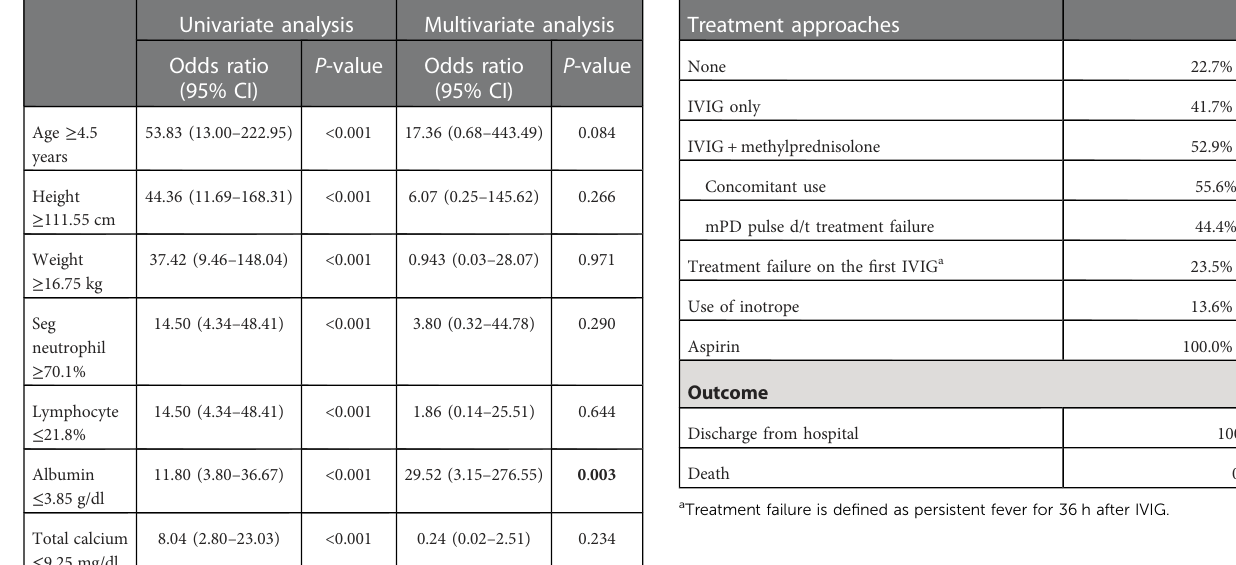
TABLE 3 Results of logistic regression analysis for predicting MIS-C.